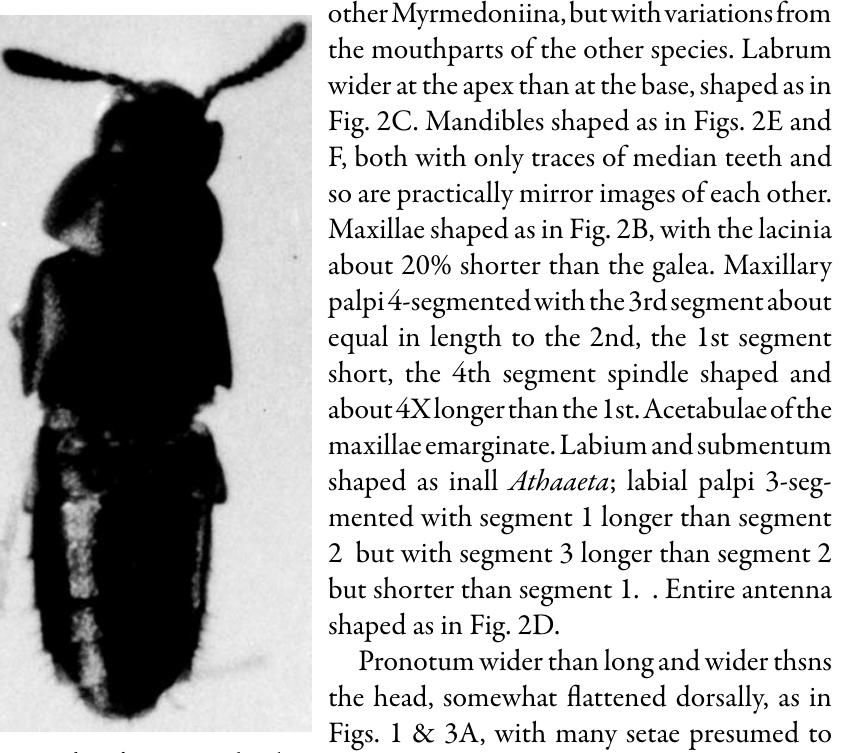
Fig. 1. Atheta dominguesae , dorsal